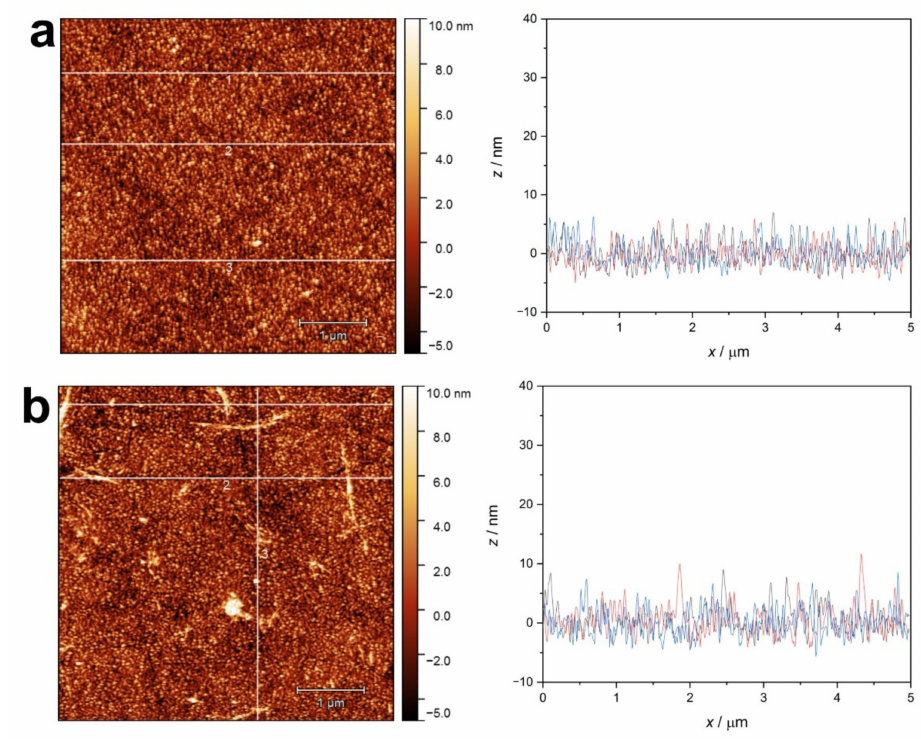
Figure 13. AFM topography images of QCM sensor crystal surfaces after adsorption of native E5 ( a ) and E5 amyloid ( b ). Line profiles at three selected positions (1 (black), 2 (red), 3 (blue)) are presented.